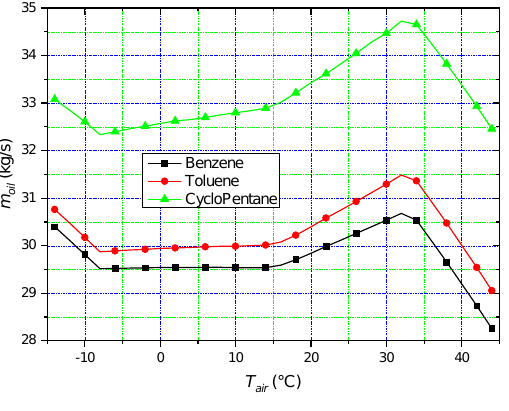
Figure 8. Diathermic oil mass flow rate varying ambient temperature.